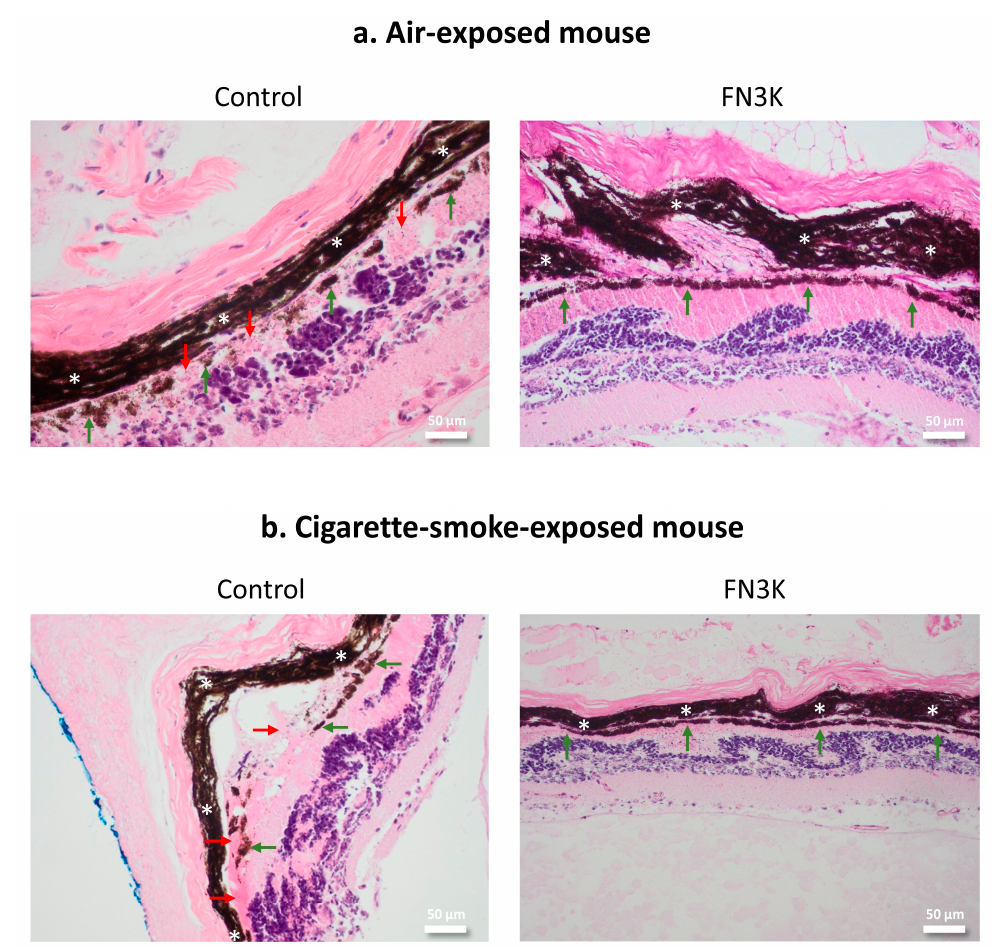
Figure 3. Hematoxylin and eosin stained tissue sections of eyes from one non-smoking mouse ( a ) and one mouse exposed to cigarette smoke ( b ) after intravitreal injection of control or FN3K treatment (magnification 20 × ). The choroid is indicated with white asterisks, drusenoid material with red arrows and the retinal pigment epithelium with green arrows. The scale bars are 50 µm.